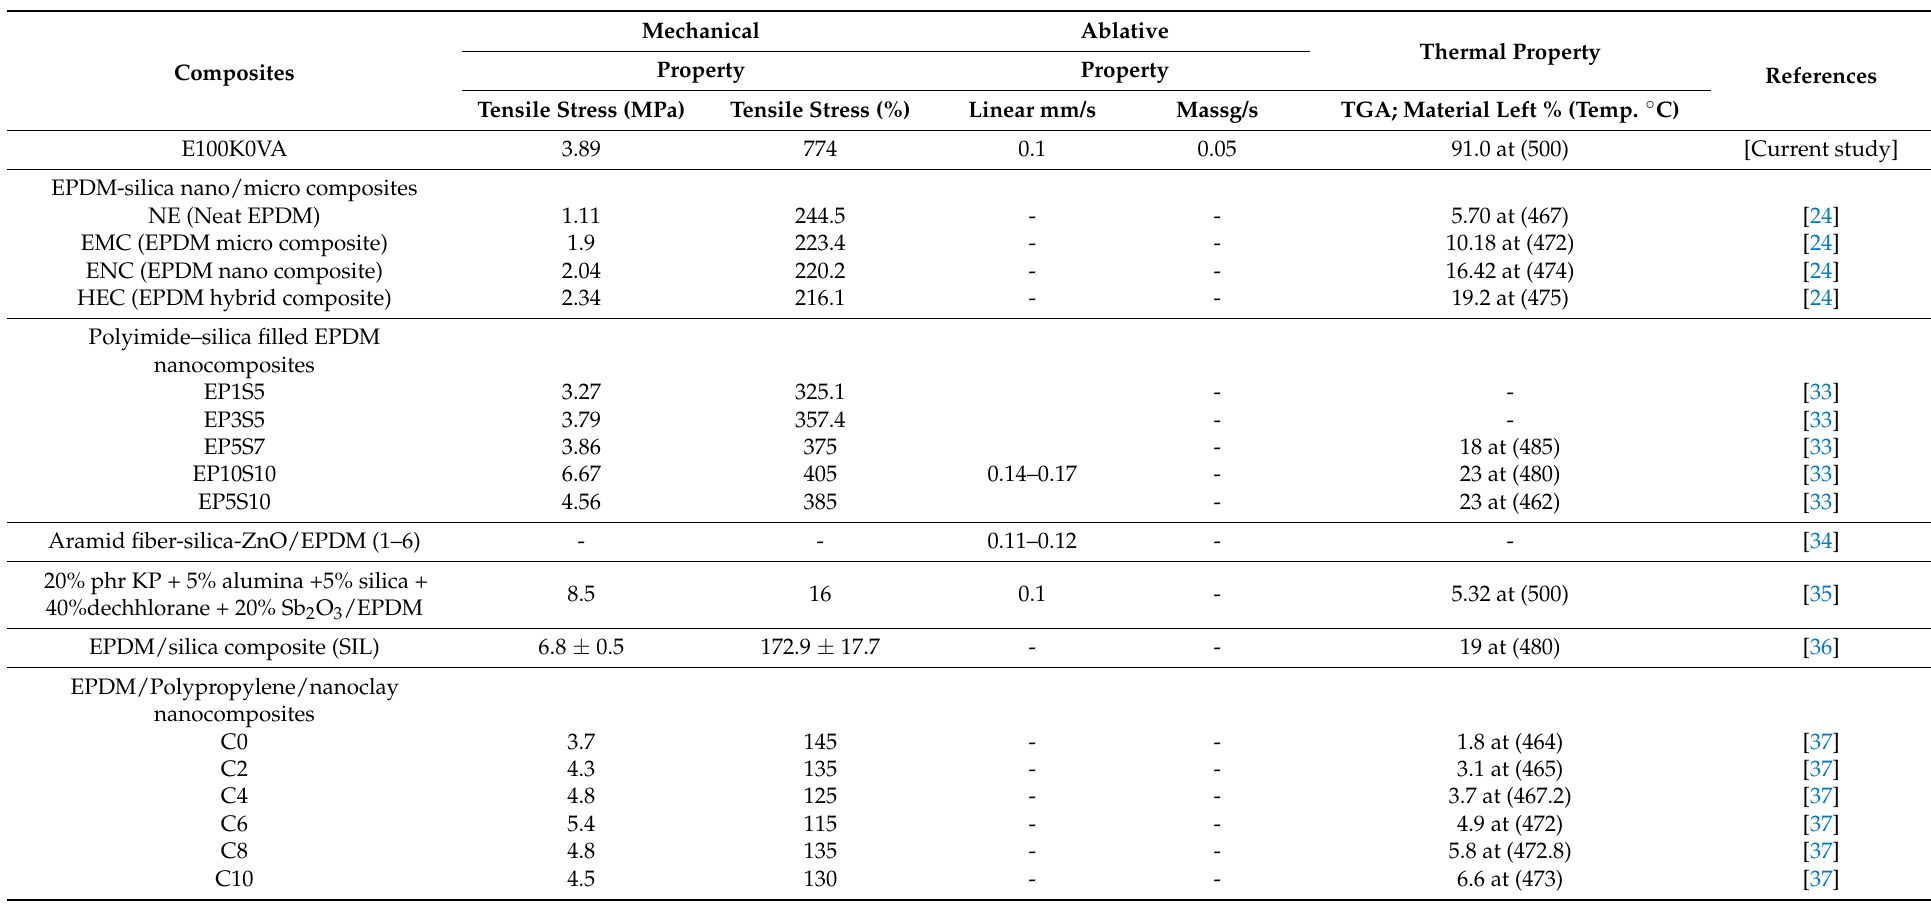
Table 4. Comparison of main parameters of EPDM-based thermal insulating systems in which silica is used as